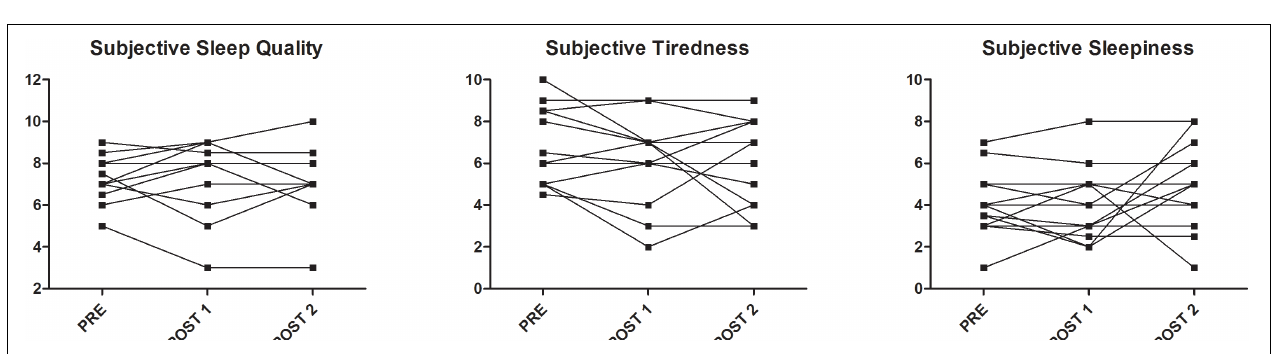
FIGURE 1 | Whiskers plot with median, first and third quartiles, and minimum and maximum values of the six actigraphy-based sleep parameters in PRE, POST 1, and POST 2.